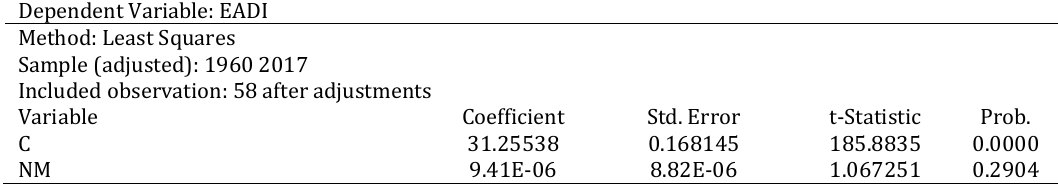
Table 10: Estimation of employment in agriculture model